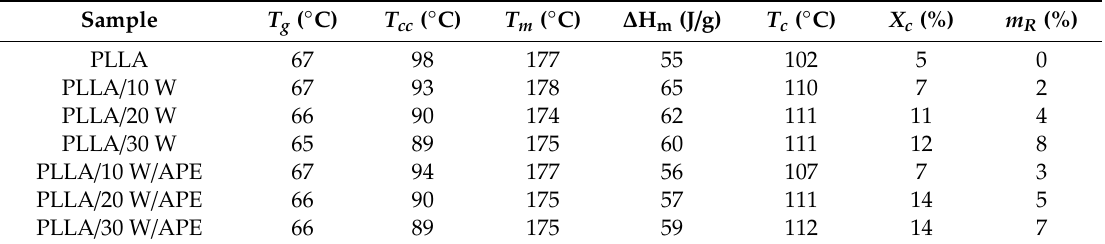
Table 2. Cold crystallization ( T cc ), melting ( T m ) and crystallization ( T c ) temperatures, onset of